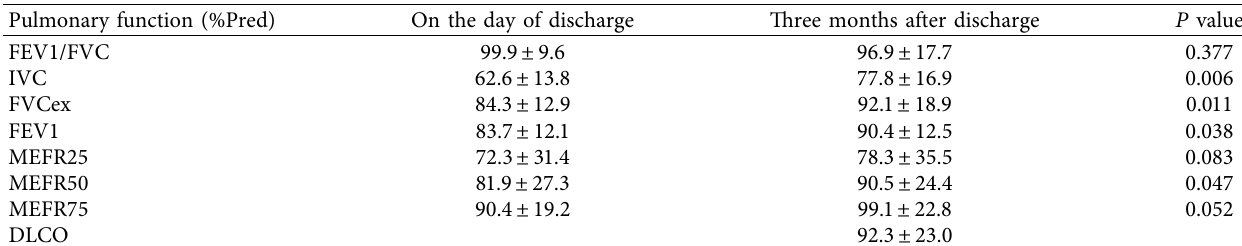
Table 3: Pulmonary function of COVID-19 patients ( n � 80).